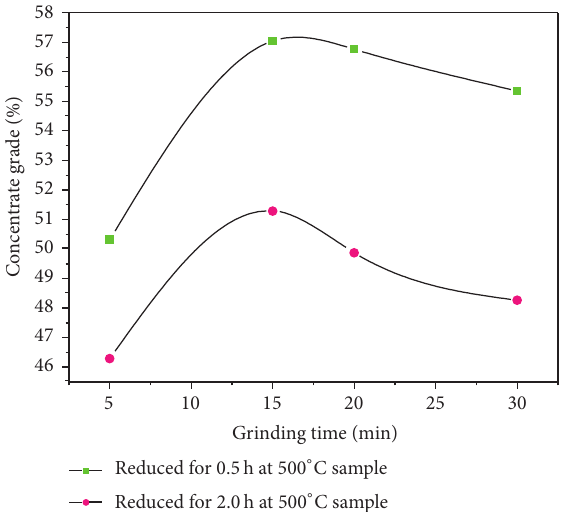
Figure 12: Effect of grinding time on the grade of the concentrate.